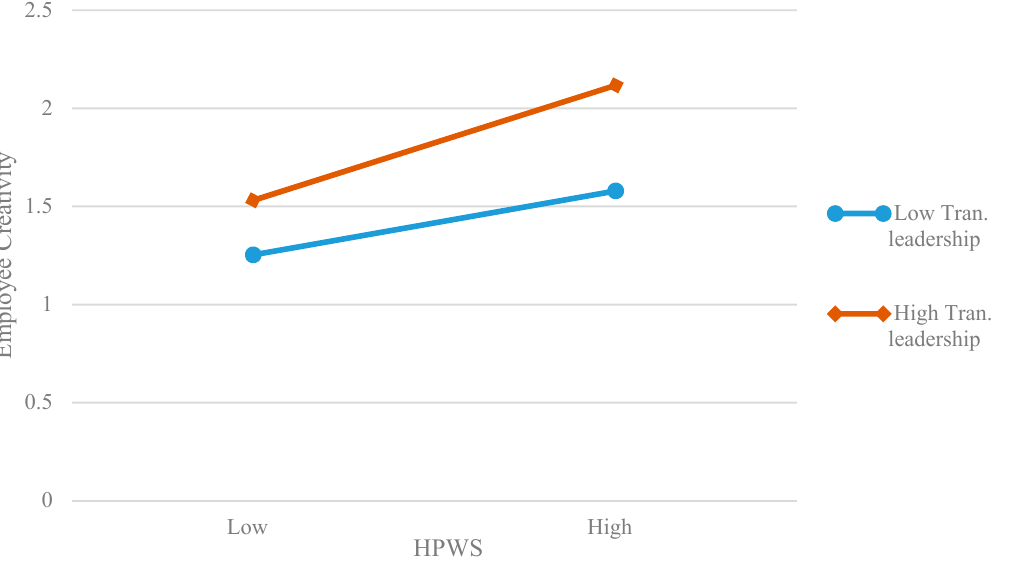
Figure 3. Moderation effect of transformational leadership on the indirect effect between a high-performance work system (HPWS) and employee creativity.